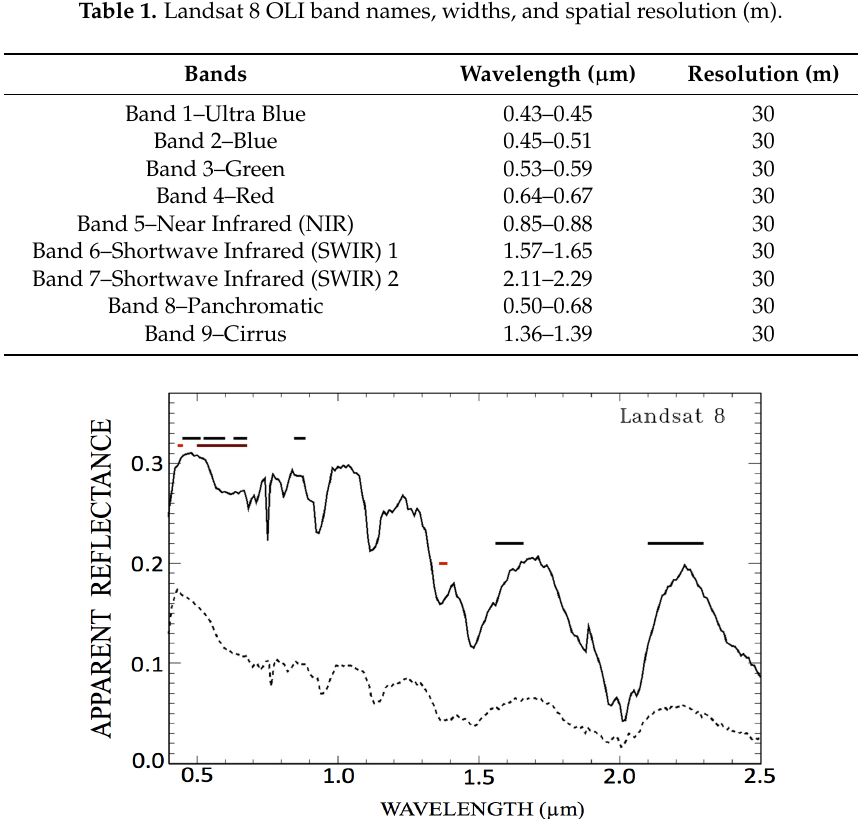
Table 1. Landsat 8 OLI band names, widths, and spatial resolution (m).